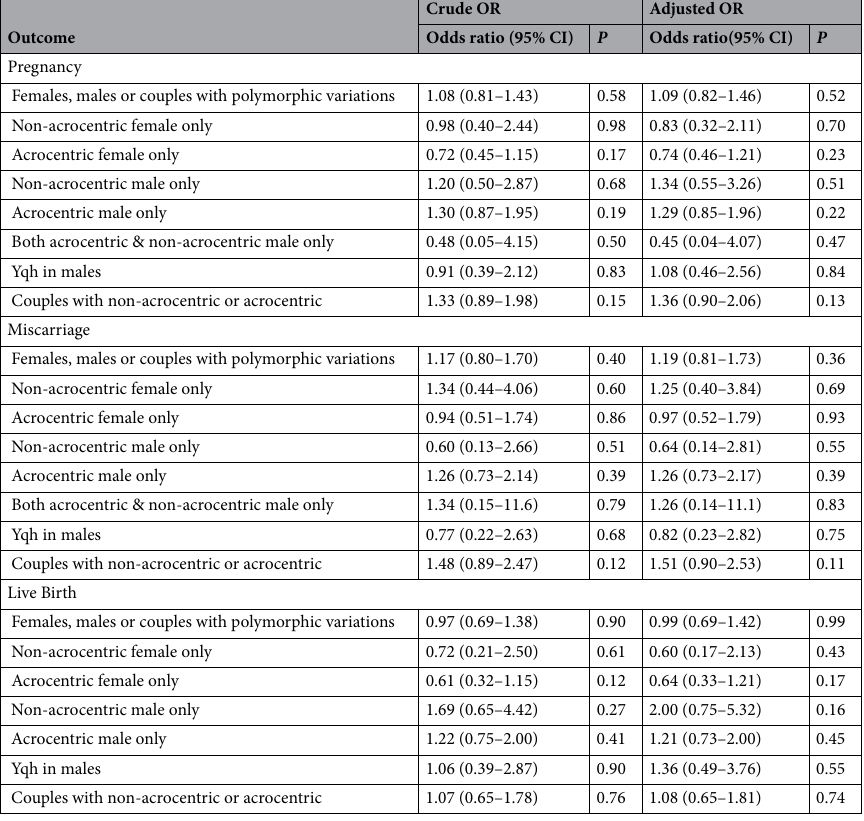
Table 4. Crude and adjusted odds ratio for pregnancy, miscarriage and live birth. The reference category is no chromosomal polymorphic variations in either partner. There were no pregnancies, miscarriages or live births recorded in both non-acrocentric and acrocentric female only groups. There were no live births recorded in both non-acrocentric and acrocentric male only group. Reproductive outcomes are adjusted for confounding variables including age, BMI, serum FSH, LH levels, and type of treatment. OR Odds ratio. CI 95% Confidence